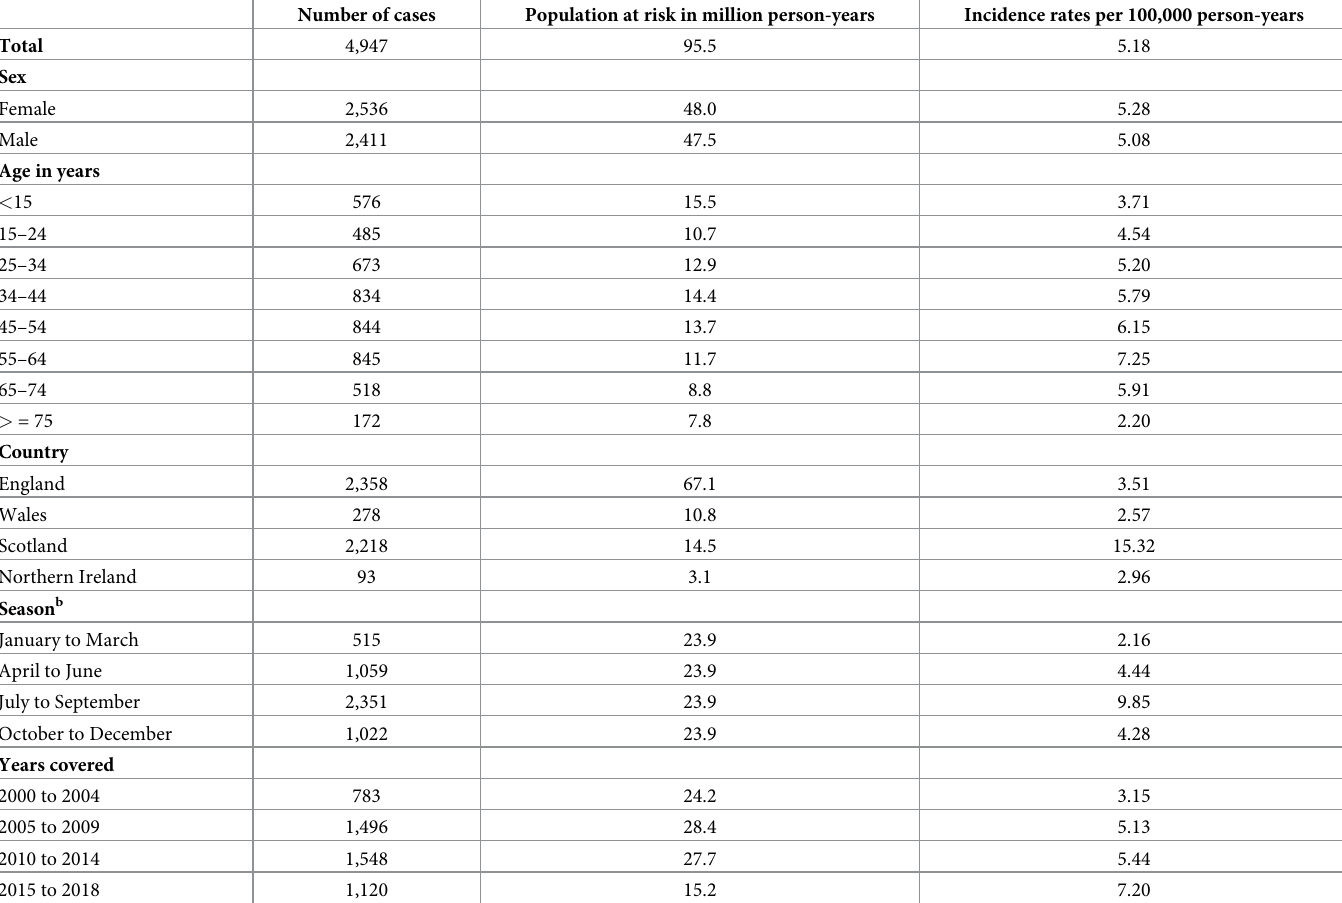
Table 1. Incidence rates of Lyme disease per sex, age, geography, and time period a